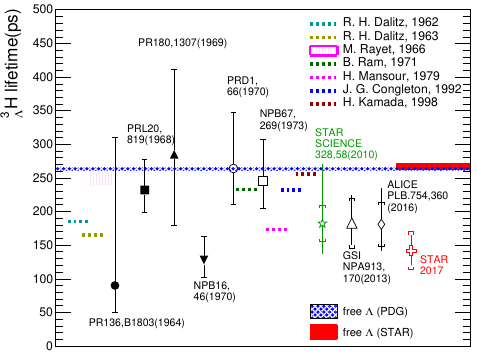
Figure 8. A summary of worldwide 3 Λ H lifetime experimental measurements and theoretical calcula- tions. The two star markers are the STAR results published in 2010 and